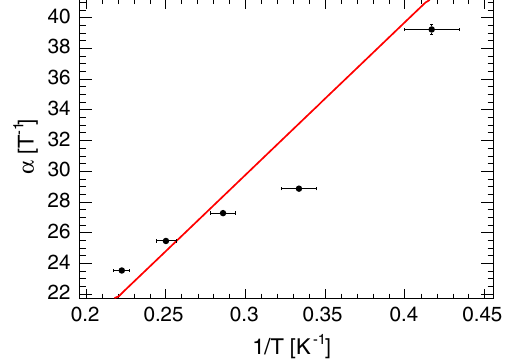
FIG. 7. Temperature dependence of the empirical fitting parameter α . The solid line shows the best linear fit without a constant term.